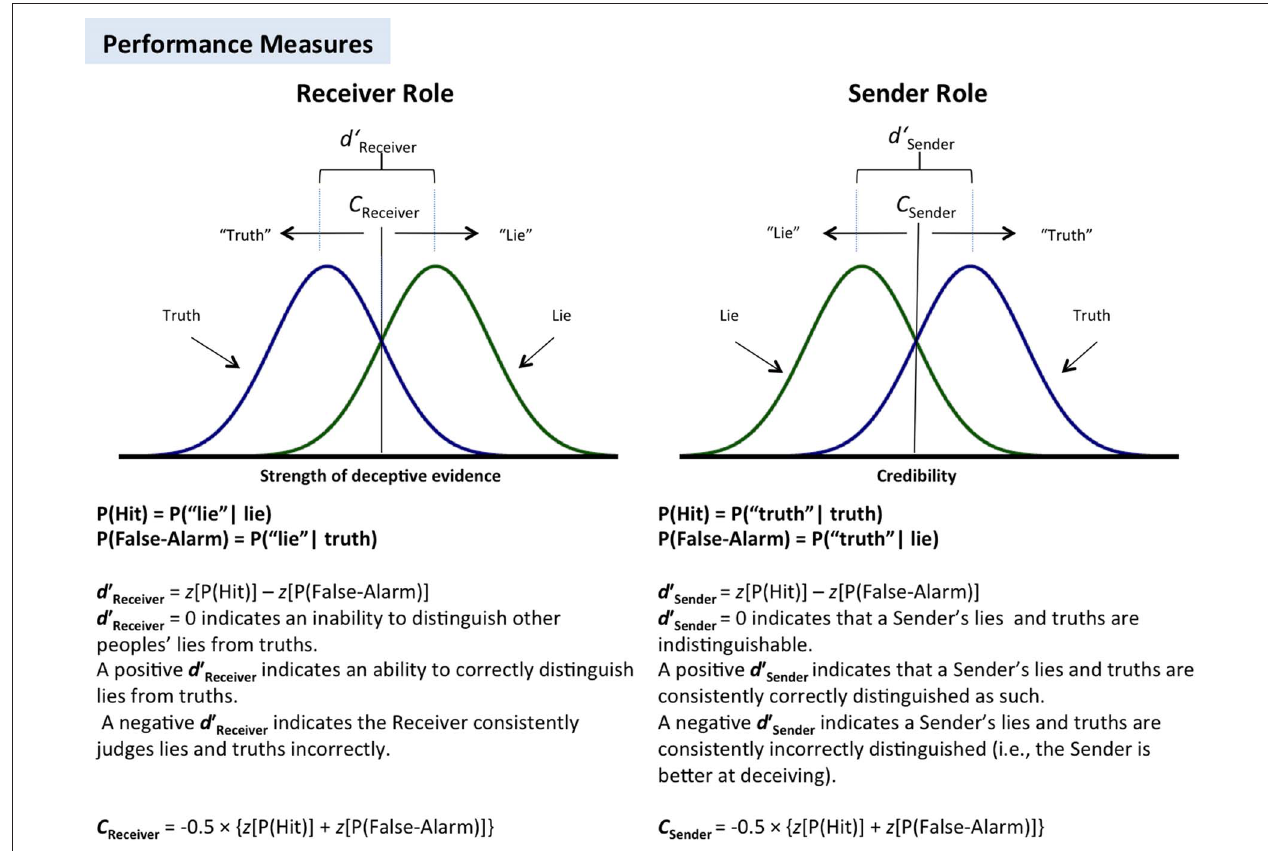
FIGURE 1 | Individual difference parameters for Senders and Receivers based on signal detection theory (SDT).